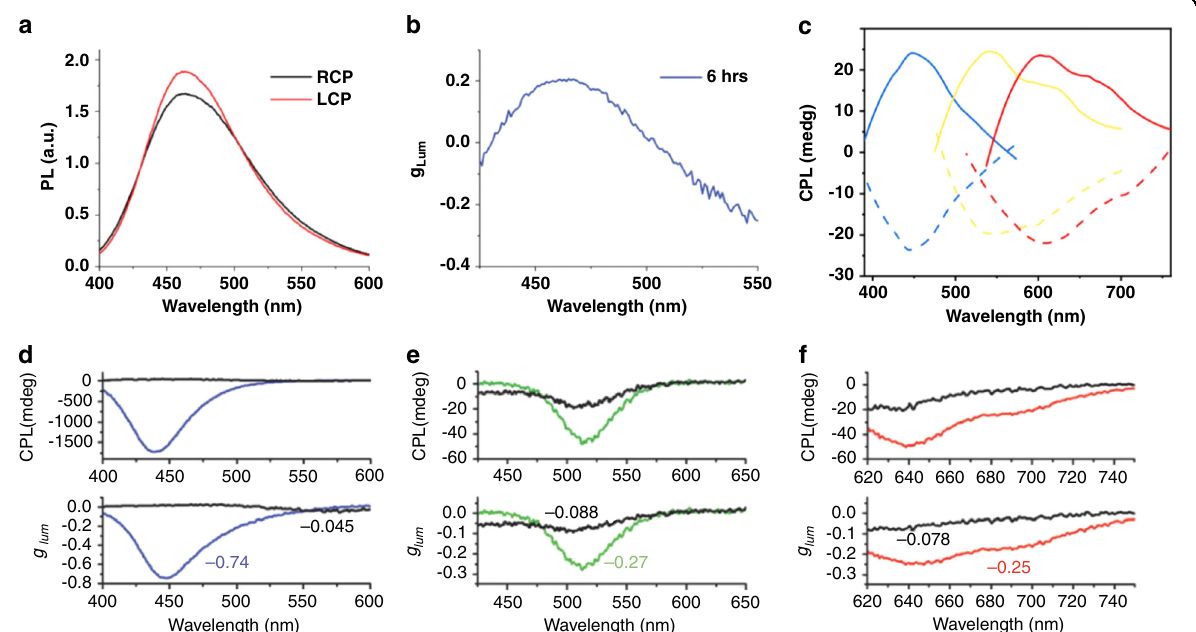
Fig. 6 CPL in chiral carbon dots. a PL spectra of carbon-dot/cellulose nanocrystals, recorded using left- and right-handed circular polarizers (LCP and RCP, respectively) and b their g Lum plotted as a function of emission wavelength. c CPL spectra of superstructures of blue, yellow, and red chiral carbon dots and glutamic diamide (solid and dotted lines show spectra of enantiomers). d – f CPL spectra and g PL of cellulose nanocrystals and blue ( d ), green ( e ), and red ( f ) carbon dots from the carbon-dot/cellulose nanocrystal composites. Colored lines show photonic band gap superimposed on emission band; black lines show photonic band gap not overlapping with emission band. a, b Adapted with permission from 63 Copyright 2019 Wiley-VCH GmbH. c Adapted with permission from 59 Copyright 2021 Wiley-VCH GmbH. d – f Adapted with permission from 64 Copyright 2018 Wiley- VCH